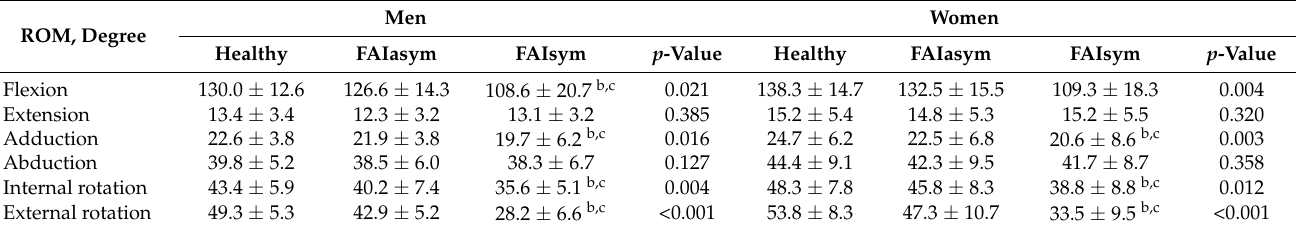
Table 3. Participant’s hip range of